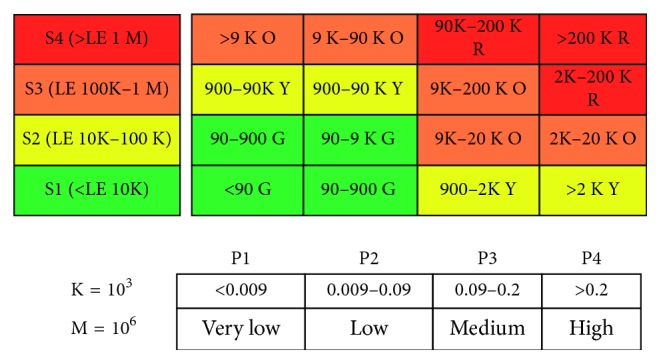
The risk matrix of the number of complaints for equipment per year, presenting the proposed scales of probability and severity.